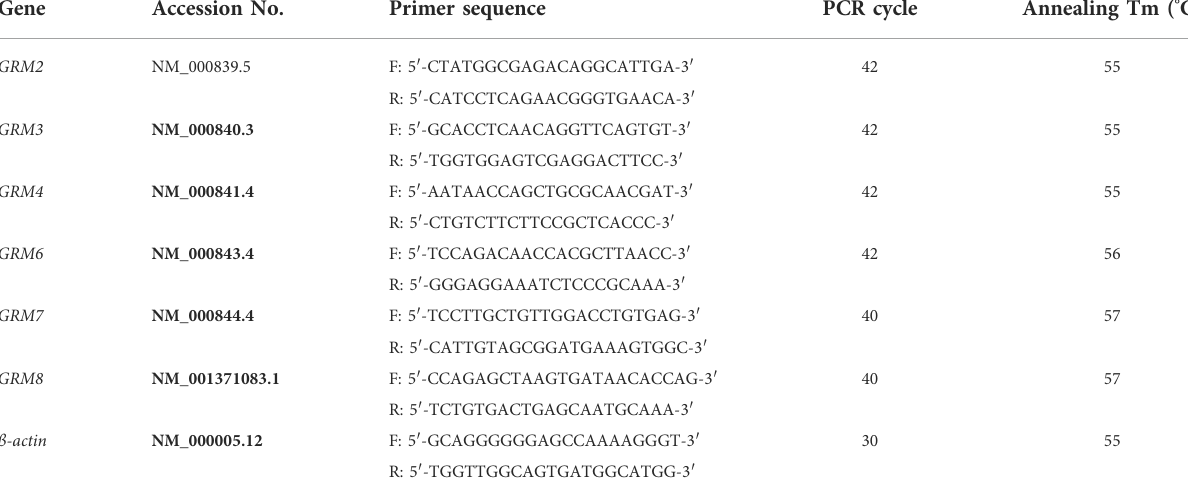
TABLE 1 Sequence of human primers used in RT-PCR experiment.